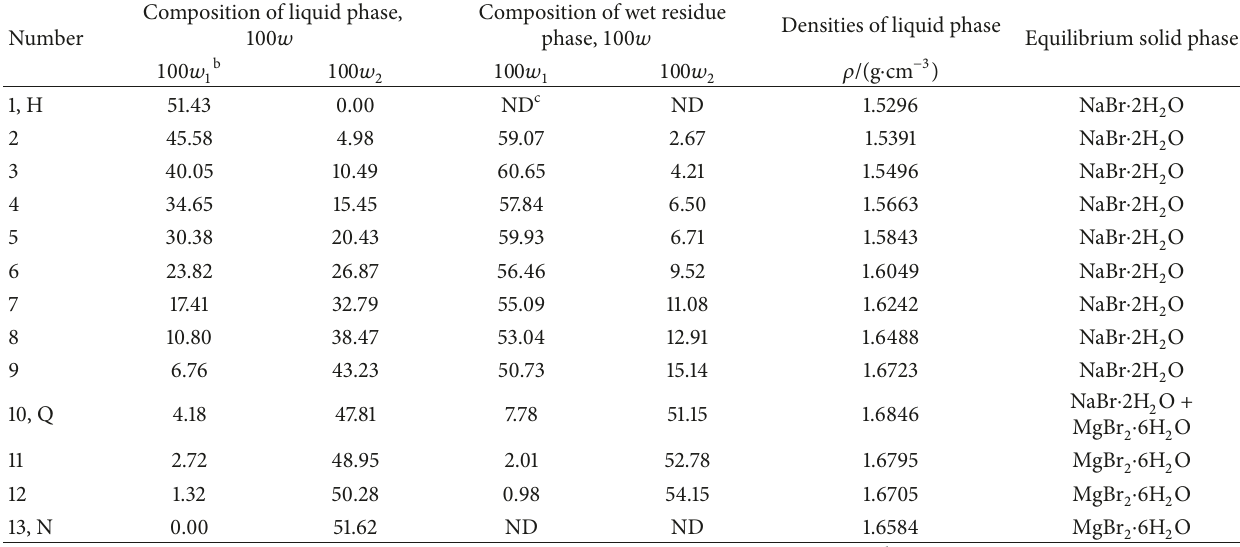
Table 3: Mass Fraction Solubility of the ternary NaBr + MgBr 2 + H 2 O system at temperature = 313.15 K and pressure = 0.1MPa a . Number